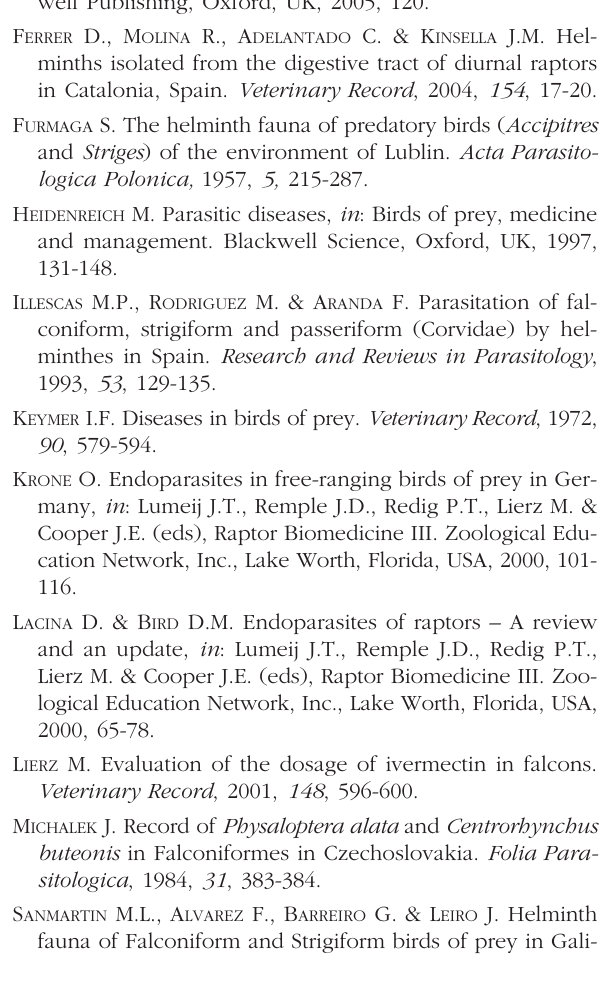
cia, Northwest Spain. Parasitology Research , 2004, 92 ,